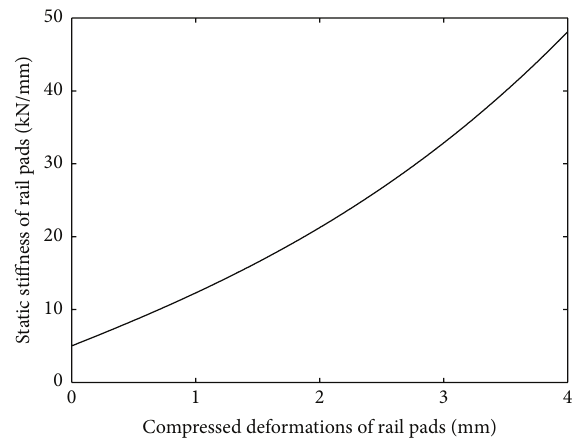
Figure 3: The stiffness-deformation curve of TPE rail pads.